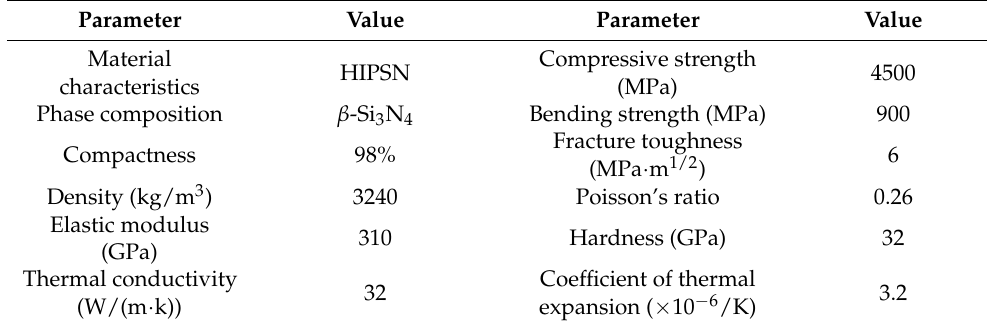
Table 1. Properties of HIPSN ceramic